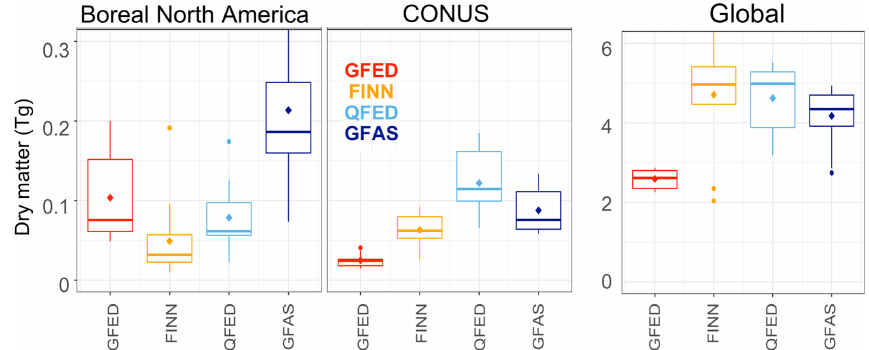
Figure 4. Boxplot summary of each inventory’s underlying total annual dry matter (DM) globally and for boreal North America and CONUS. The conventions of this boxplot are described in Fig. 2. GFED4s DM emissions are in red, FINN1.5 emissions in orange, QFED2.4 effec- tive DM emissions in light blue, and GFAS1.2 effective DM emissions in dark